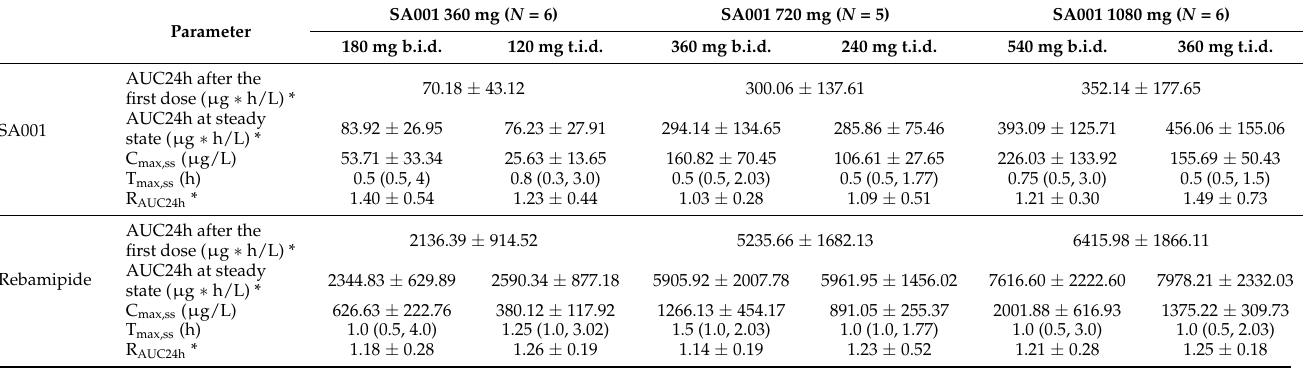
Table 2. Pharmacokinetic parameters of SA001 and rebamipide at steady state after multiple oral administration of